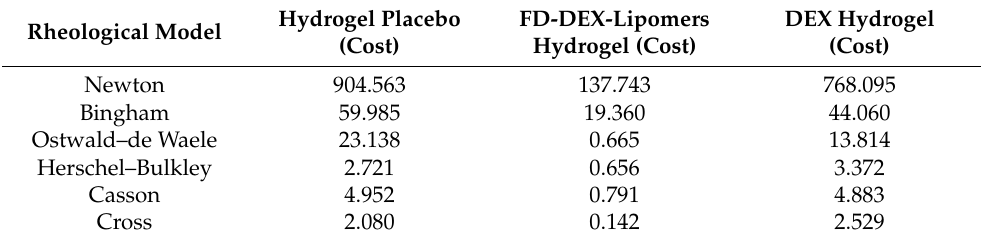
Table 5. Rheological model fitting of hydrogel placebo, dexamethasone hydrogel, and freeze-dried dexamethasone lipomers